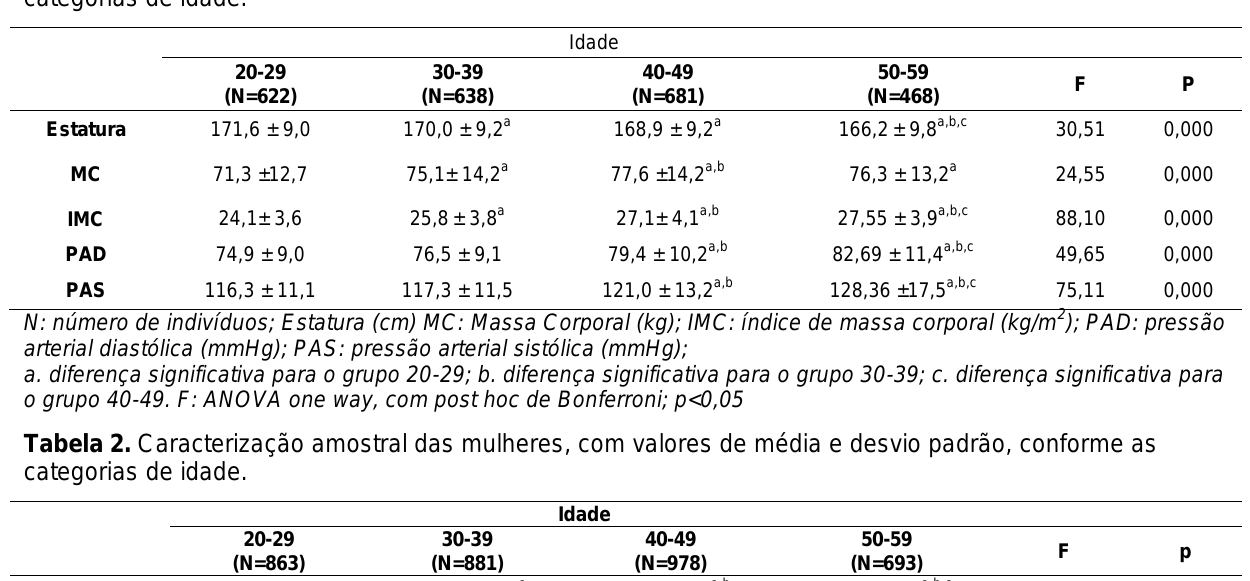
Tabela 1. Caracterização amostral dos homens, com valores de média e desvio padrão, conforme as categorias de idade.